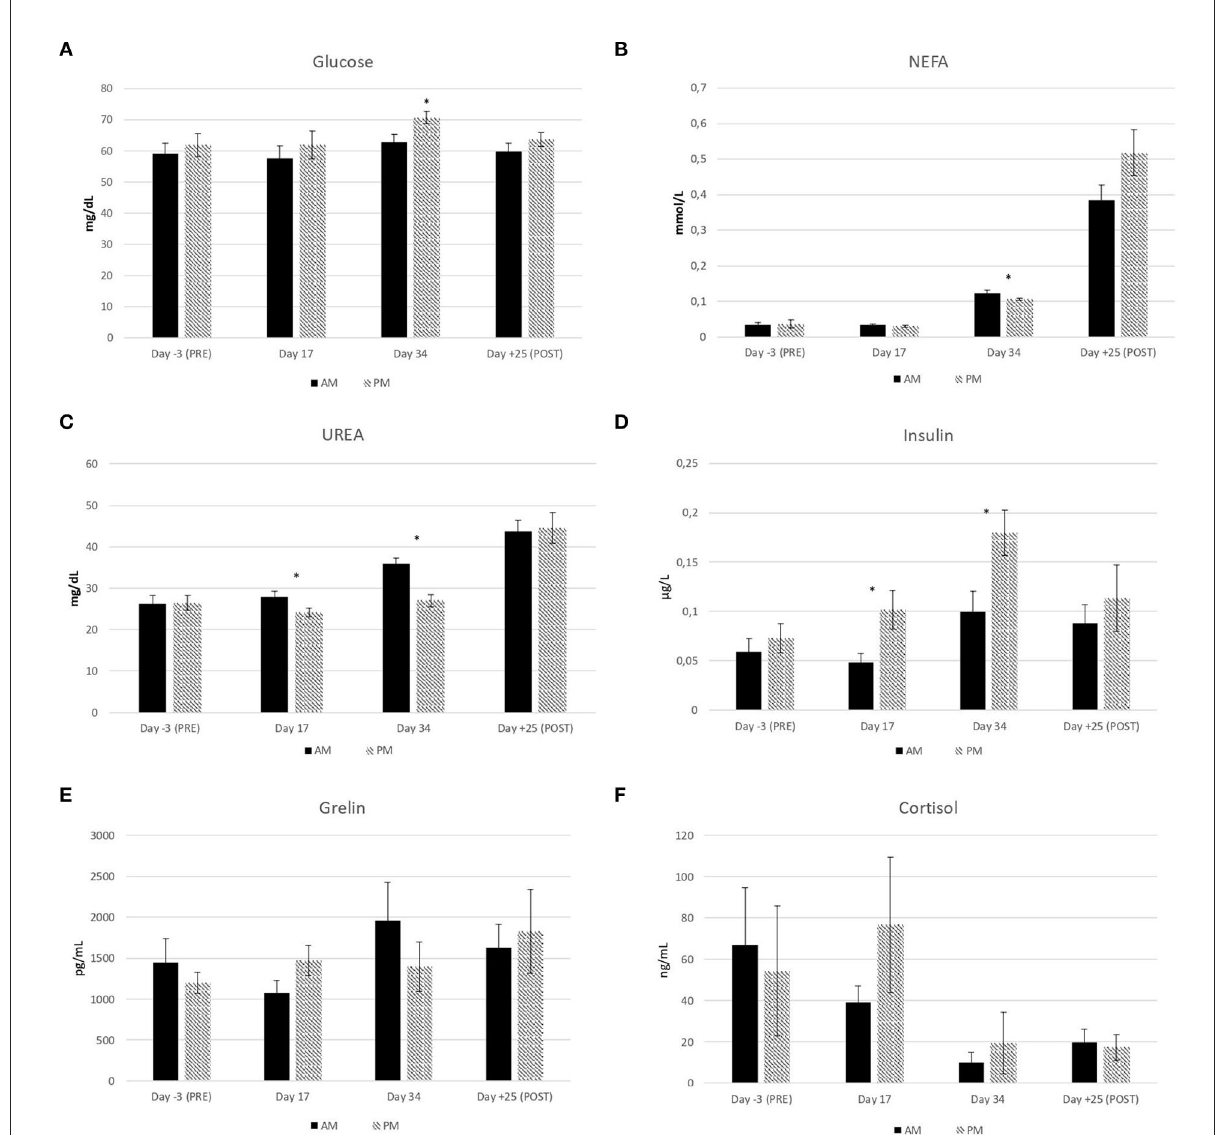
FIGURE2 Effect of the timing of pasture allocation on plasma metabolites and hormone concentrations at T0 (basal level) on the sampling days before [day-3 (PRE)], during (day 17 and day 34) and after [day + 25 (POST)] the experiment in ewes either allocated to pasture 4h daily in the morning (AM) or in the afternoon (PM). n = 12 ewes per